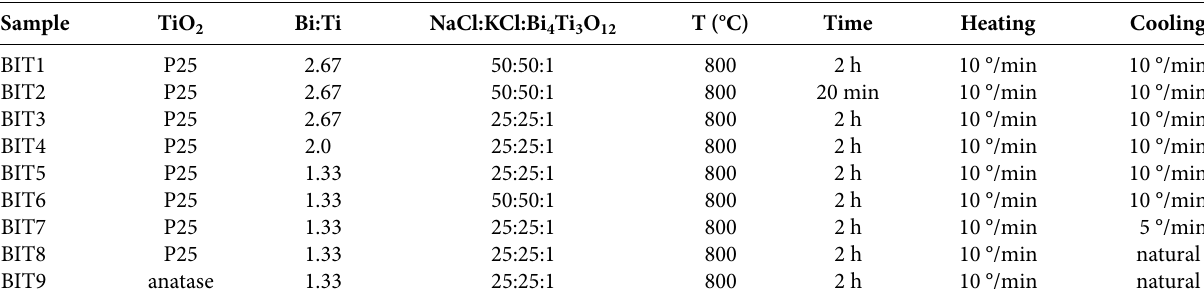
Table 1 : Reaction conditions of BIT1-BIT9 for the investigation of the influence of the reaction parameters on the morphology and crystal structure of Bi 4 Ti 3 O 12